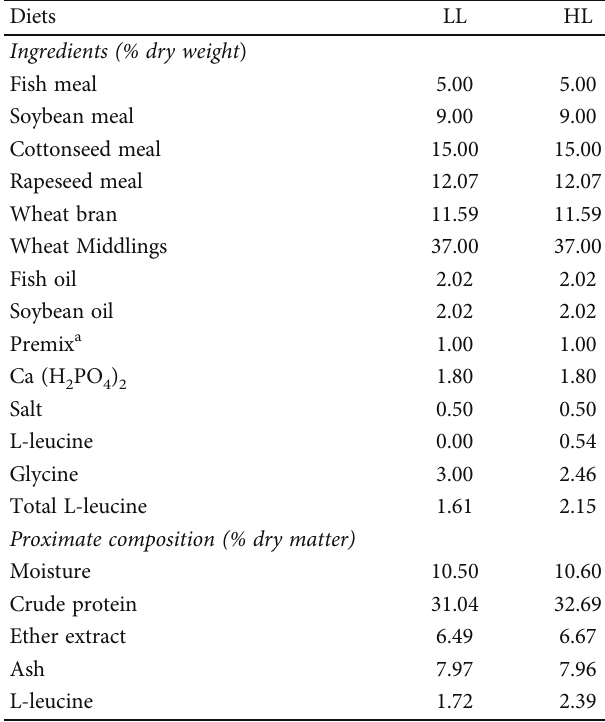
Table 1: Formulation of the di ff erent experimental diets (air-dry basis,